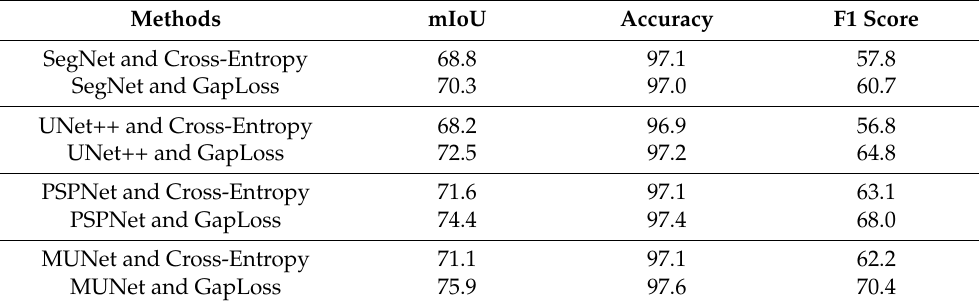
Table 2. The results of DeepGlobe Roads